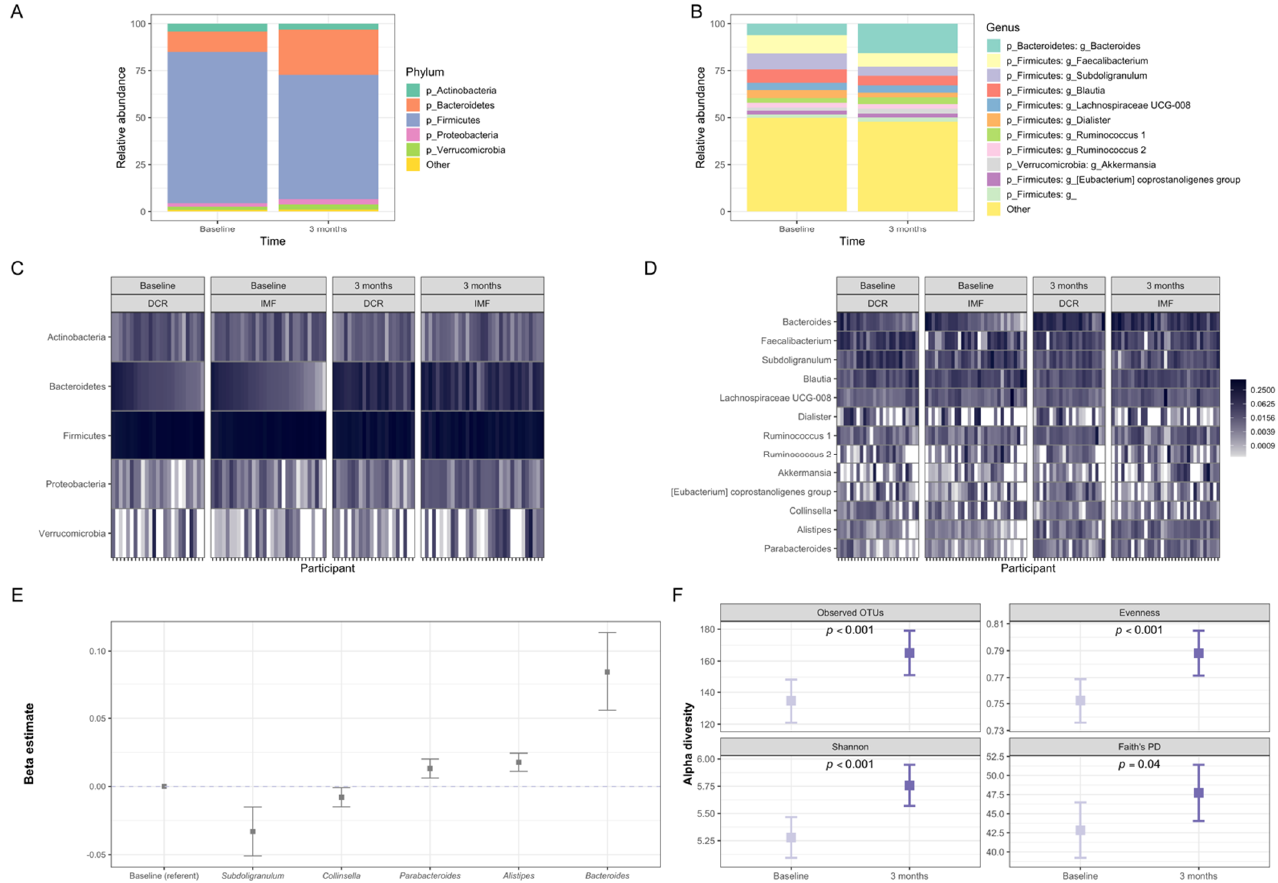
Figure 3. Changes in the overall gut microbiota of DRIFT2 participants from baseline to three months. The overall gut microbiota community structure (beta-diversity) shifted significantly from baseline to three months ( p < 0.001 for weighted and unweighted UniFrac metrics). ( A ) Average relative abundance of the most prevalent gut microbiota phyla among study participants at baseline ( n = 56) and three months ( n = 55). ( B ) Average relative abundance among study participants at baseline ( n = 56) and three months ( n = 55) of the most prevalent gut microbiota genera and those that changed significantly from baseline to three months. ( C ) Relative abundance of the most prevalent gut microbiota phyla for DCR and IMF study participants at baseline ( n = 25 DCR/31 IMF) and three months ( n = 22 DCR / 33 IMF). ( D ) Relative abundance of the most prevalent gut microbiota genera and those that changed significantly for DCR and IMF study participants at baseline ( n = 25 DCR / 31 IMF) and three months ( n = 22 DCR/33 IMF). ( E ) Gut microbiota taxa showing significant (FDR p < 0.1) overall change from baseline to three months. The y-axis shows the regression estimate from longitudinal models (using the ANCOM method, controlling for age, sex, intervention group, time and an interaction between intervention group and time, for n = 104 samples from 52 individuals) for the scaled proportion relative abundance of each taxa (with one unit corresponding to one standard deviation) on the x-axis at three months relative to baseline. (F) These plots show the change from baseline to three months for four indices of alpha-diversity: Observed OTUs, Evenness, Shannon diversity index, and Faith’s Phylogenetic Diversity. These indices reflect different aspects of diversity, such as the richness, evenness, and phylogenetic relatedness of the organisms detected in the samples. All alpha-diversity indices increased significantly over the first three months of the intervention based on linear mixed models of the 111 samples from 59 individuals, controlling for age, sex, intervention group, and time (interactions between intervention group and time were not significant and, thus, not included). OTUs: operational taxonomic units (clusters of organisms that are grouped by gene sequence similarity); PD: Phylogenetic